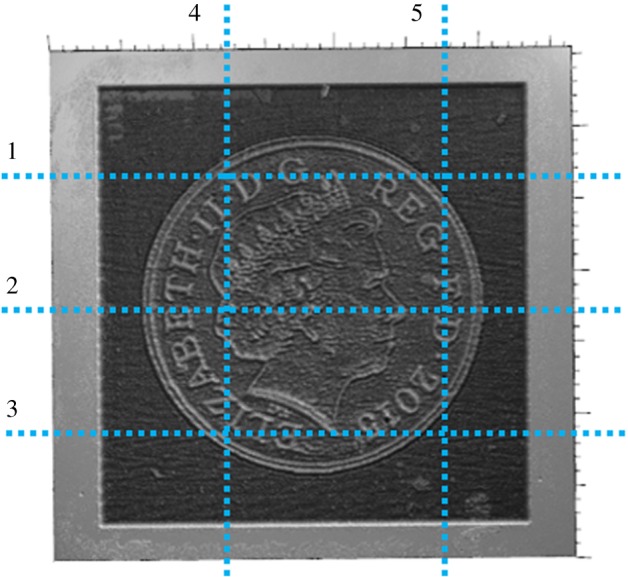
The profiles plotted in figure 24.